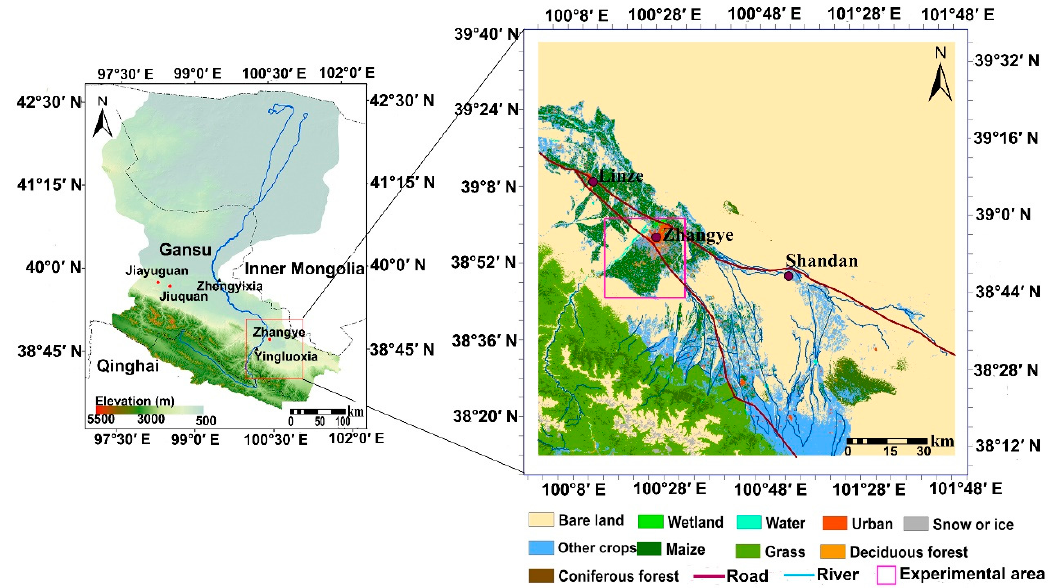
Figure 1. Location of study area. A 30 km × 30 km experimental region was set up in the study area.